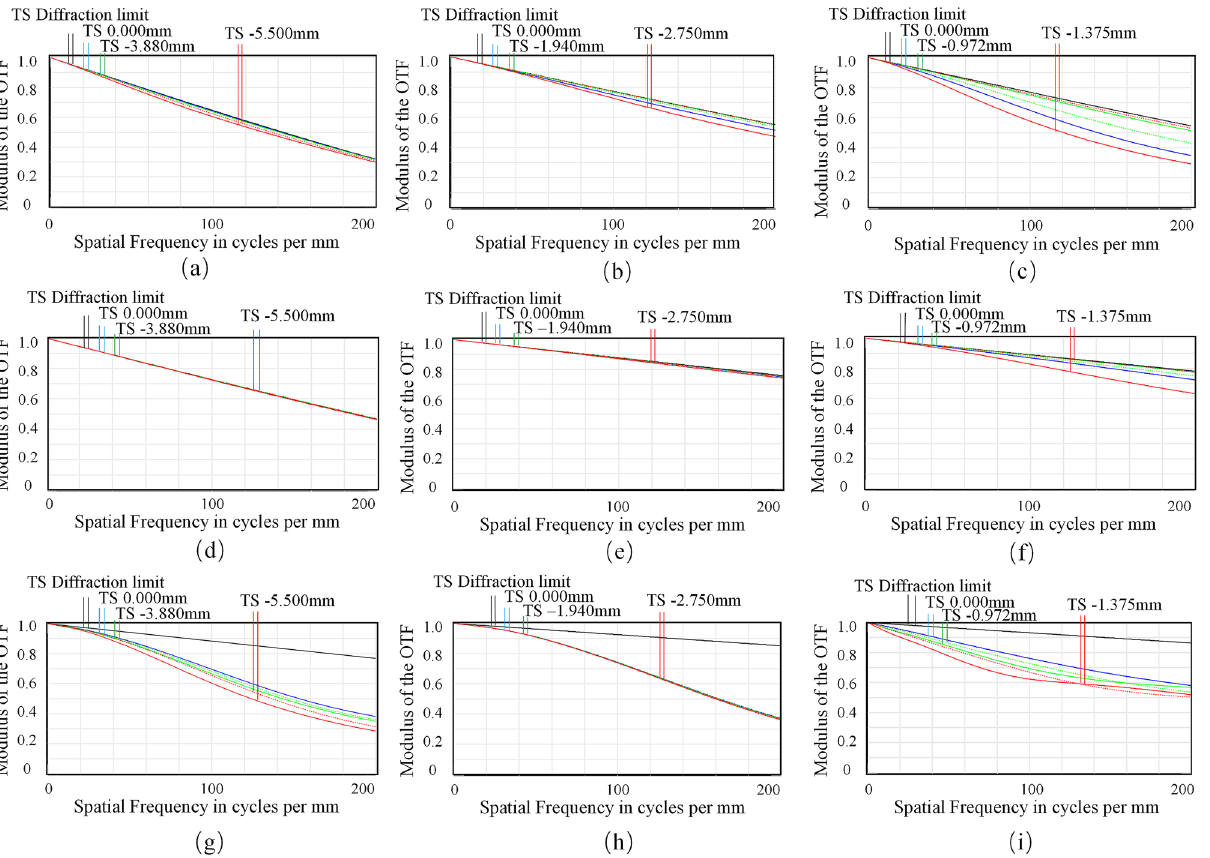
Figure 7. The corresponding diffraction MTF at different magnifications (M) and focal distance (z). ( a ) M = 10×, z = 1 mm. ( b ) M = 10×, z = 3 mm. ( c ) M = 10×, z = 3.5 mm. ( d ) M = 20×, z = 1 mm. ( e ) M = 20×,